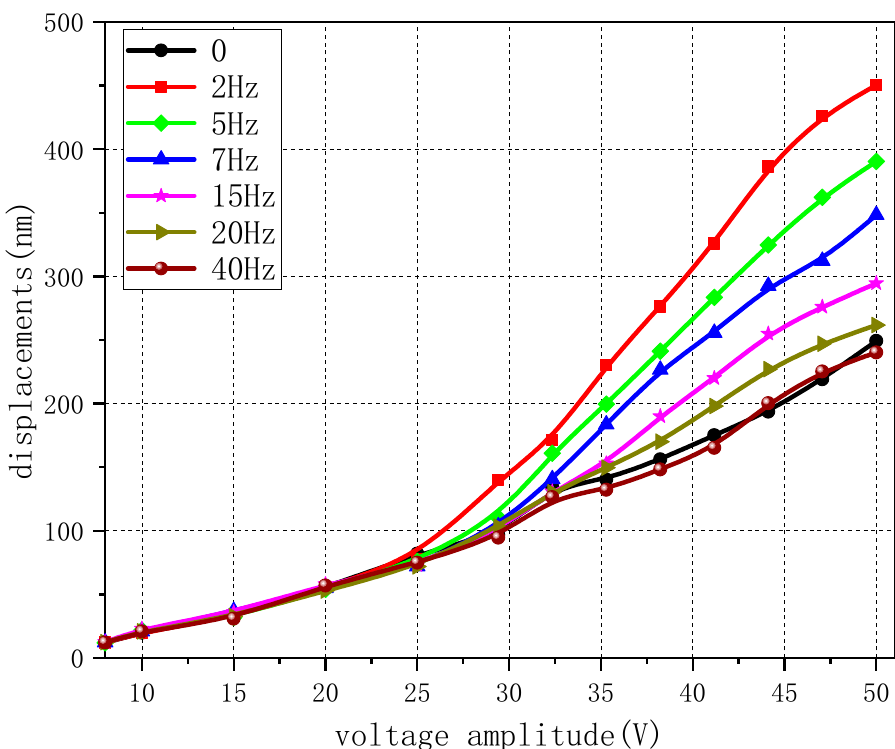
Figure 6. The peak-to-peak value of core vibration displacement. From the overall trend analysis in the figure, it is found that the lower the inter- harmonic frequency, the greater the peak-to-peak value of the core vibration displacement, but in different frequency ranges, the increase in amplitude varies greatly. When the frequency of inter-harmonics is less than 20 Hz, the amplitude of vibration increase is much greater than when the frequency is greater than 20 Hz. For example, when the fundamental voltage amplitude is 50 V, the peak-to-peak displacement under excitation with 2 Hz inter-harmonic component is 450.3 nm, which is 1.8 times that of excitation without an inter-harmonic component. The excitation with 20 Hz inter-harmonics is only 1.05 times the peak-to-peak value of vibration without inter-harmonic excitation. Figure 7 shows the time-domain waveform of the vibration displacement of measur- ing point 1 without inter-harmonic excitation. It can be seen from Figure 7b that when the transformer core is in normal working conditions, the frequency spectrum is mainly concentrated on even-numbered components such as 100 Hz and 200 Hz. It also contains a small number of odd harmonics, and they are basically concentrated below 500 Hz. Due to the experimental environment and core resonance, there are some interference signals in the range of less than 20 Hz. The existence of interference signals may be caused by problems such as experimental equipment and the iron core manufacturing process. When the excitation does not contain inter-harmonics, there will be some interference signals in the spectrogram, and the difference between the interference signal and the main sig- nal is about ten times, so it is considered that the interference signal will not affect the experimental